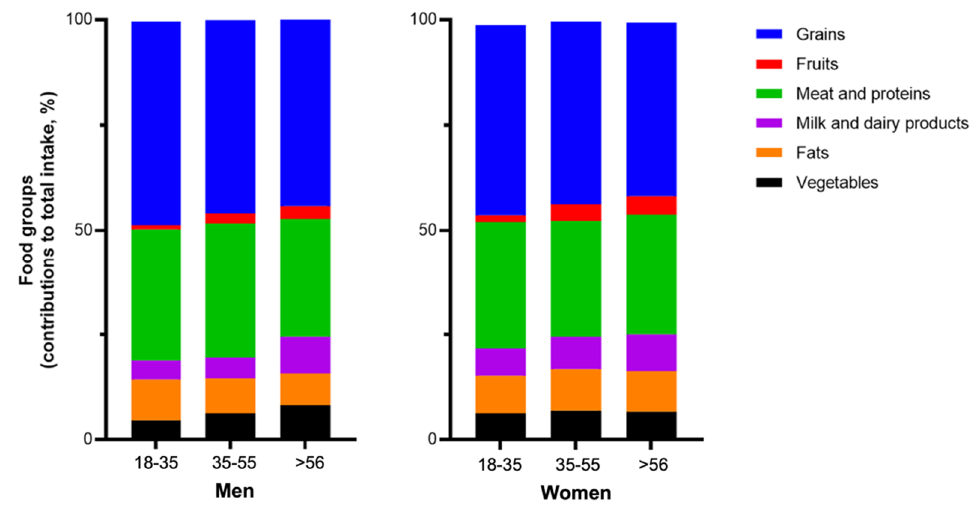
Figure 3. Contribution of food groups to total energy intake by gender and age (years).